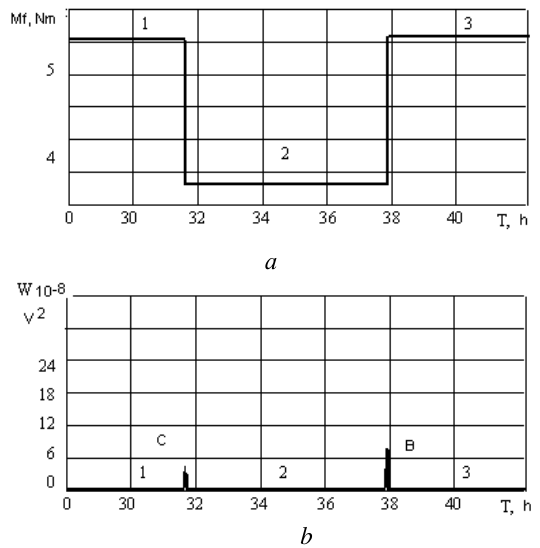
Fig 2. Associations of М f ( а ) and average power signals W from time (friction pairs with MCL). Value of loading